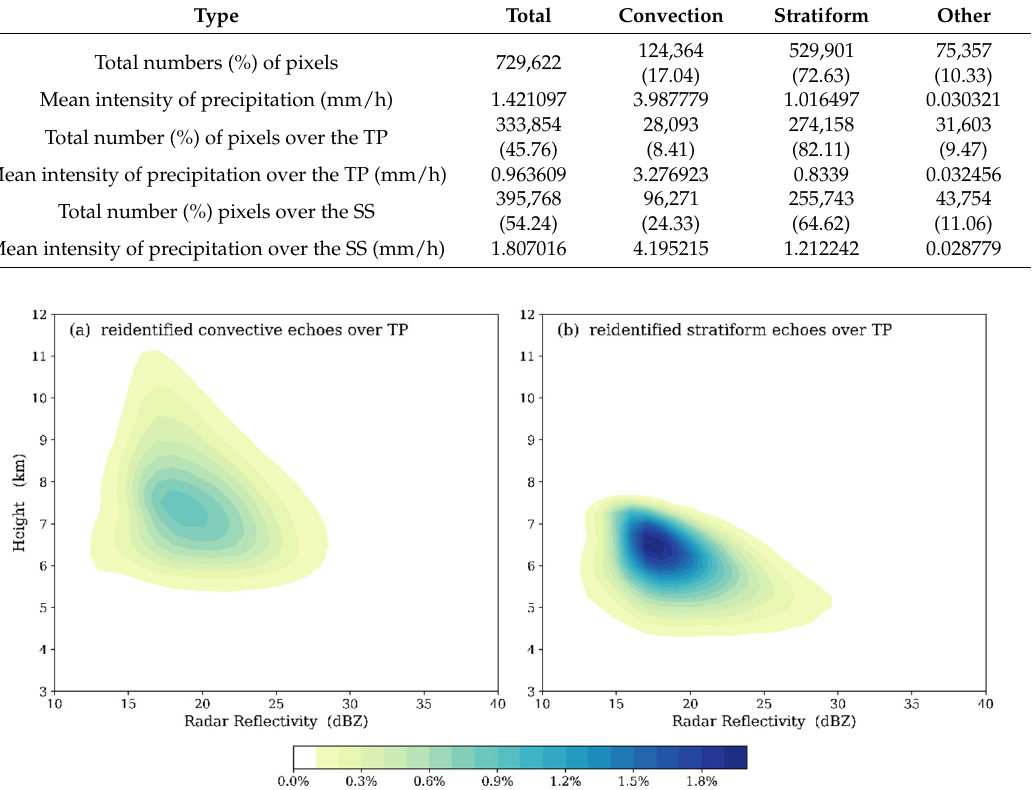
Table 1. Number, percentage, and mean intensity of precipitation in pixels for different types of precipitation.